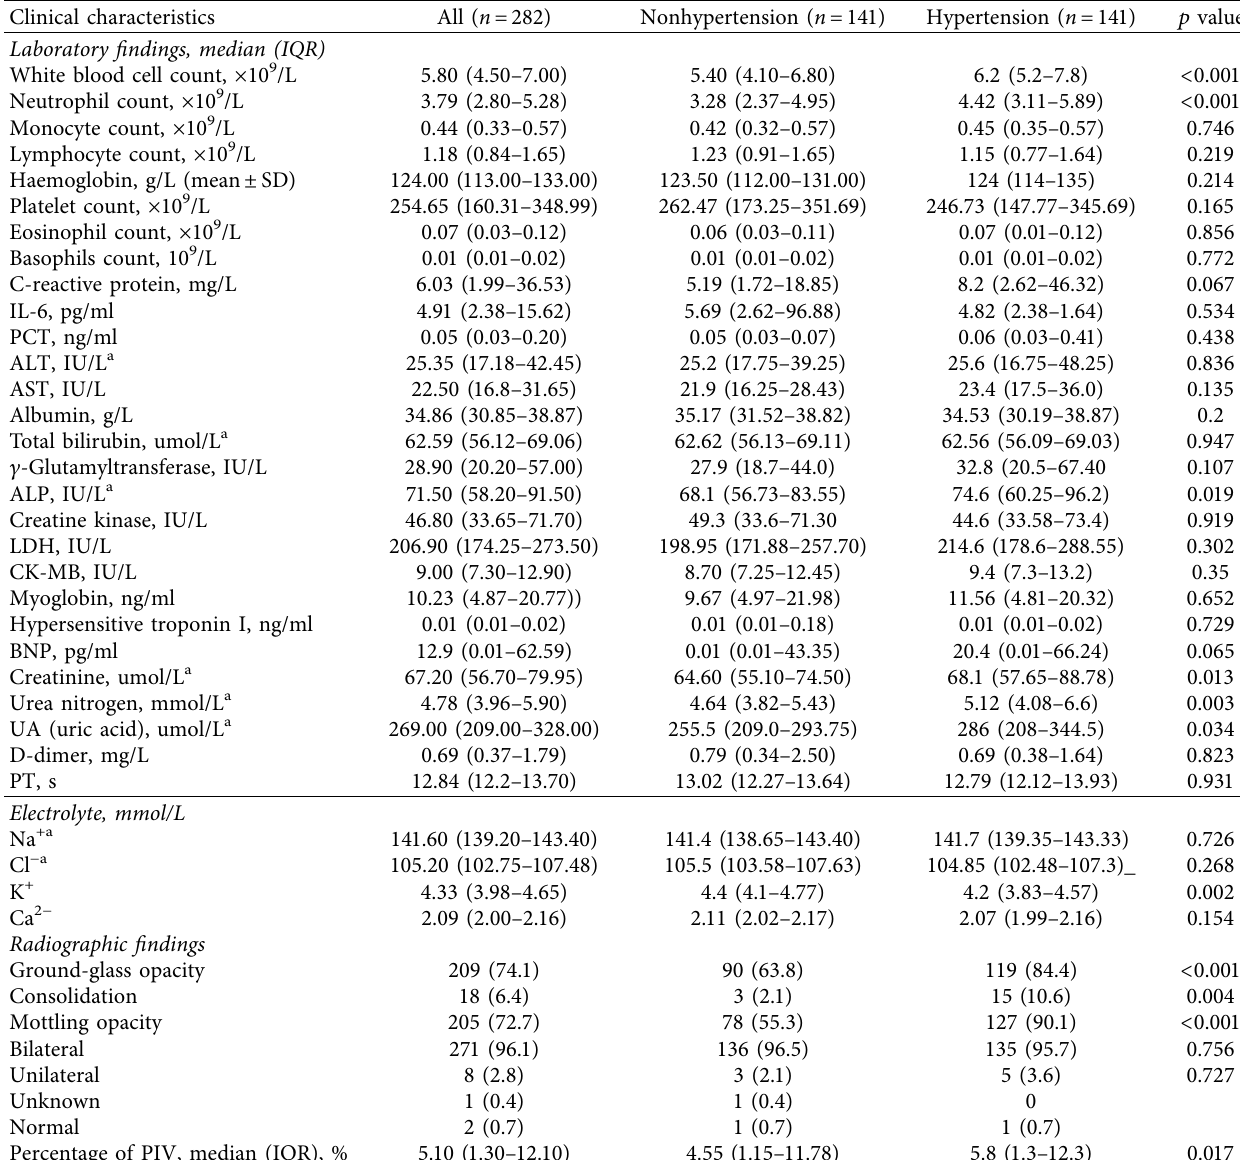
Table 2: Laboratory and radiographical findings of 282 patients with COVID-19 on